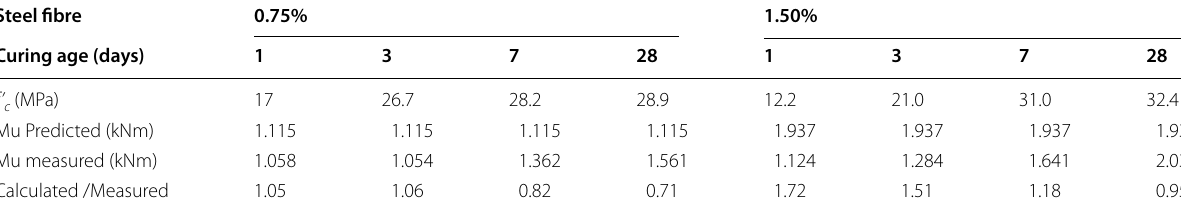
Table 8 Calculated ultimate moment capacity Steel